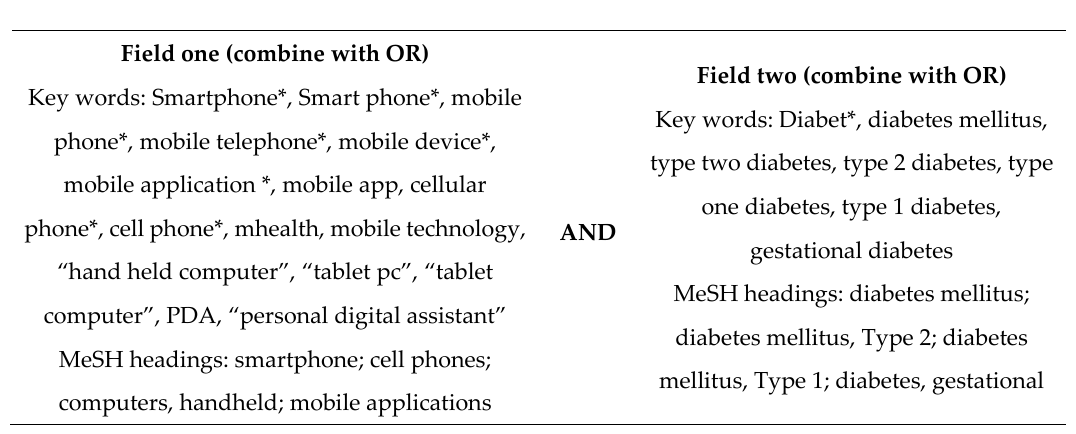
Figure 1. Search strategy used in the systematic literature review of the effect of using mobile devices to record food or nutrient intake on diabetes control and nutrition outcomes. * used to retrieve unlimited suffix variations.